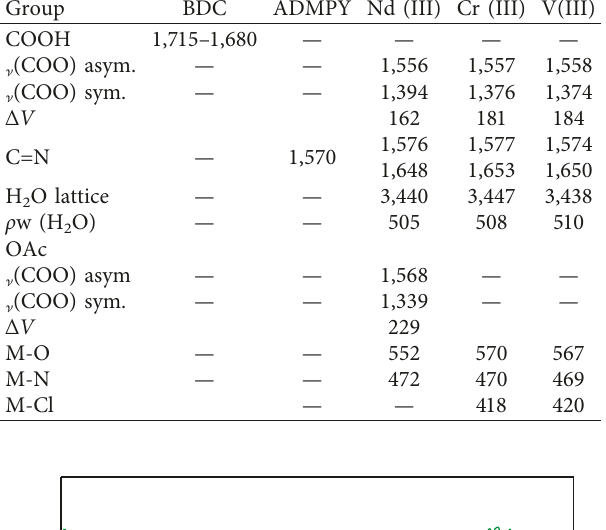
1, 2, and 3 are the numbers of three compounds. Table 3: FT-IR spectral data of ligands and their metal complexes. Group